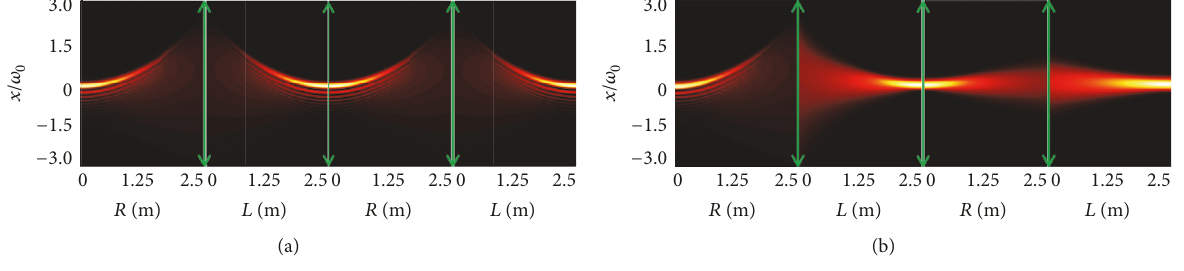
Figure 5: Side view of Airy beam propagating in each RHM and DNM unit changing with two different collision frequencies 𝛾 𝑒 . (a) 𝛾 𝑒 = 0.2 THz; (b) 𝛾 = 20 𝑒